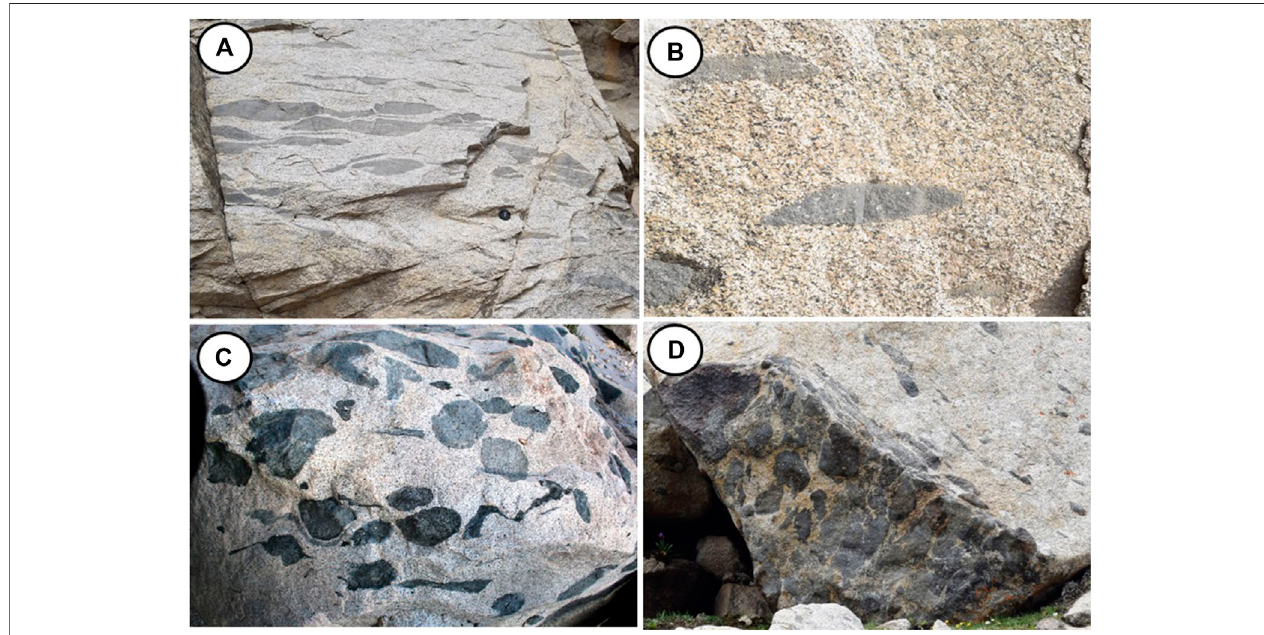
FIGURE5|(A , B) Elongatedandstretchedenclavesfollowa fl owdirectionofhostgranitemagma. (C , D) Transverseandlongitudinalsectionsofoutcropsshowing diverse geometry of numerous enclaves that suggest the chaotic nature of some enclaves.